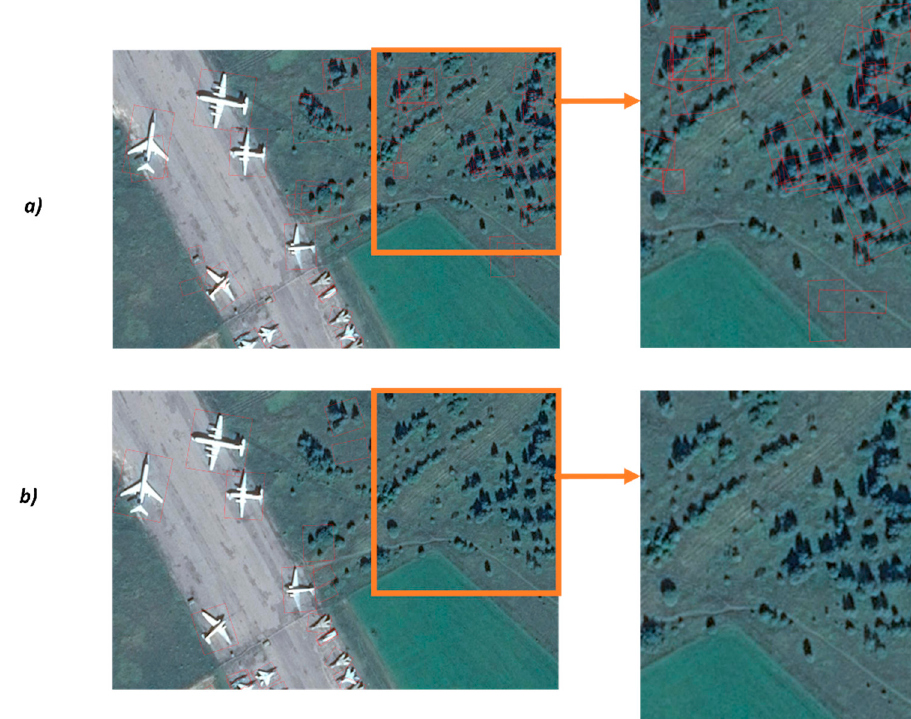
Figure 5. Comparison of detection result. ( a ) Faster R-CNN; ( b ) Faster R-CNN + background filtering module.